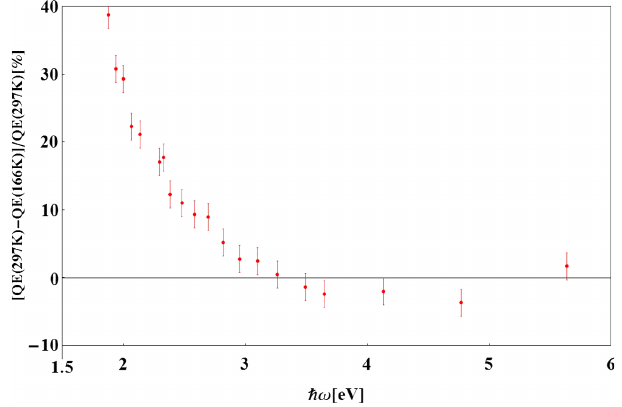
FIG. 3. The percentage of QE change from RT to 166 K as a function of the photon energy. The negative change is from the measurement